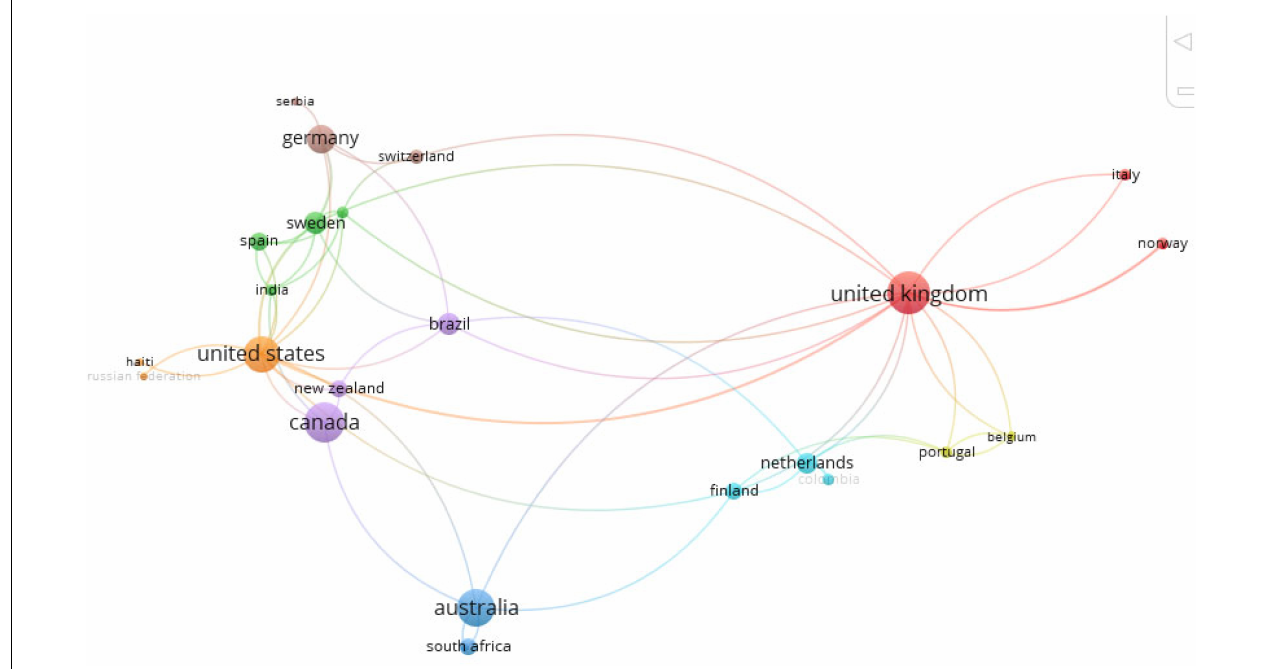
FIGURE 5 | Collaboration network (only the countries that show some collaboration in the publication of a document appear in the image; prepared by authors).